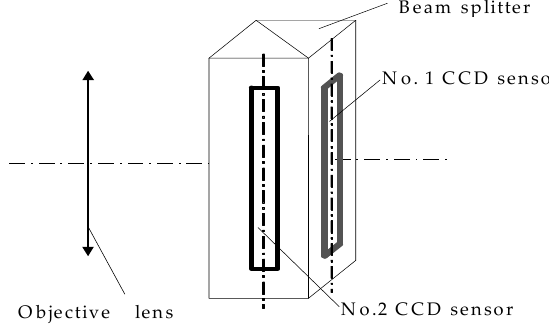
Figure 2. Schematic of sub-pixel imaging using beam splitter.